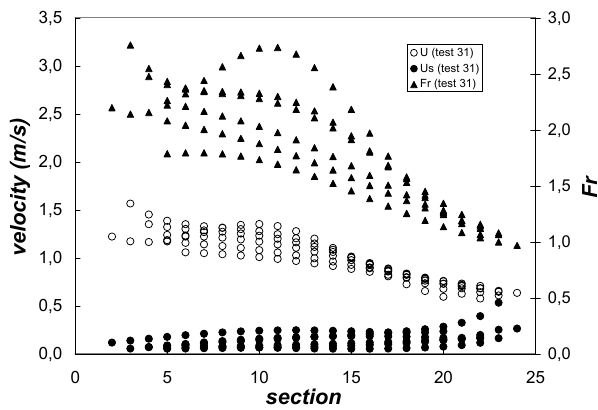
, t ..) of moving layer thickness, h , 1 2 s decreases in time, following s